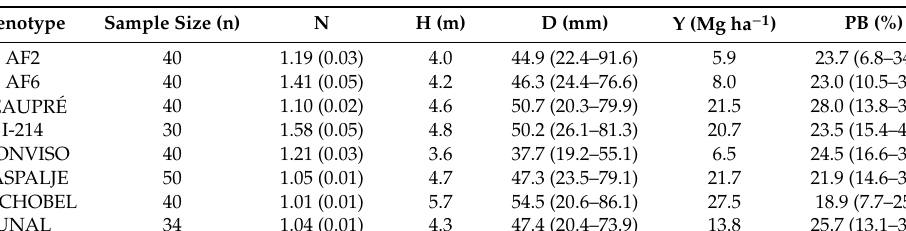
Table 1. Dendrometric information of the samples and total yield of each genotype. N stands for number of shoots per stool. H refers to the height of the dominant shoot in the stool. D refers to basal diameter. Y is yield of first rotation. PB is the proportion of branches. Average value and range for basal diameter and proportion of branches.